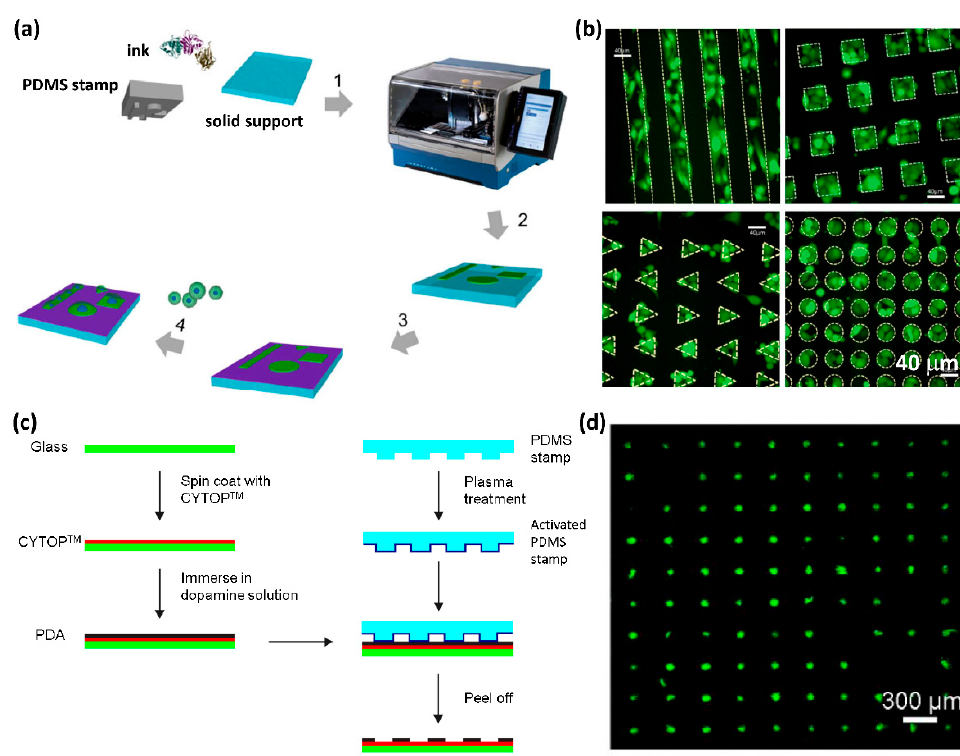
Figure 1. ( a ) Overall microcontact printing of adhesive patterns using InnoStamp 40. ( b ) Fluorescence images of PC3-GFP cells immobilized on fibronectin micropatterns of various shapes. Patterns are depicted in dashed lines. Scale bar: 40 µm. Reproduced with permission from [59]. ( c ) Schematic illustration of the fabrication of polydopamine patterns on CYTOP-coated glass surface by negative microcontact printing. ( d ) Confocal image of the patterned single mouse mesenchymal stem cell array on polydopamine patterned CYTOP surface. Reproduced with permission from [60].